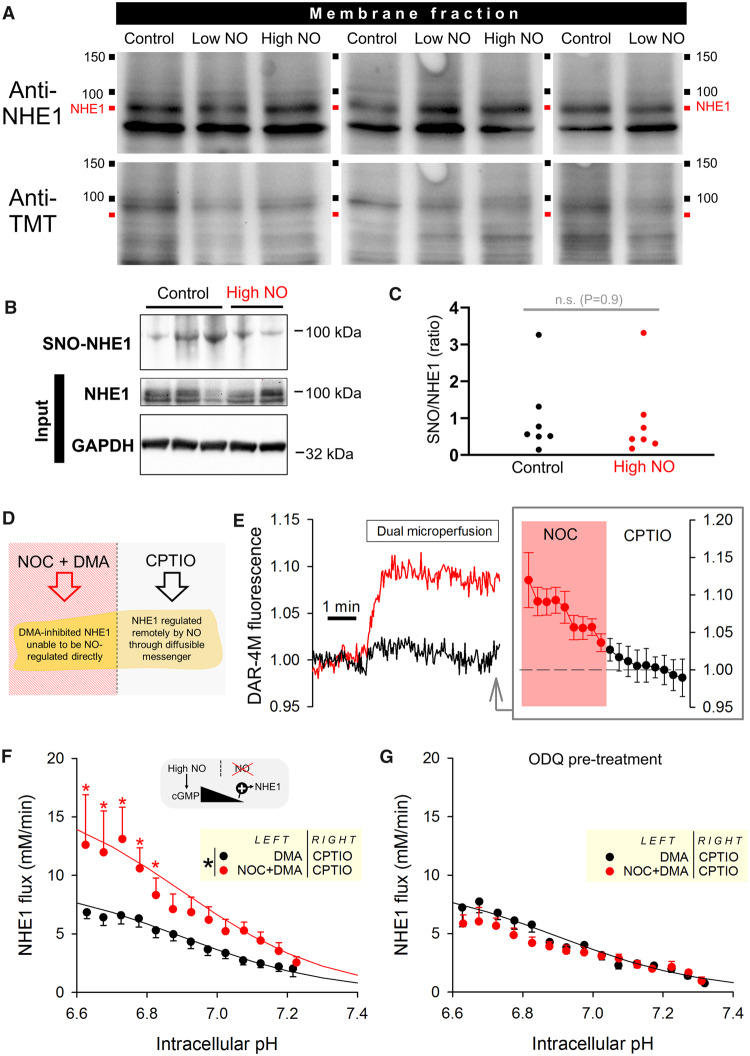
NO regulates NHE1 activity via a diffusible messenger and not via S-nitros(yl)ation. (A) Hearts were Langendorff-perfused with normal Tyrode, or Tyrode with high (5 µM NOC12) or low (300 µM NOC12 + 100 µM CPTIO) [NO]. S-nitros(yl)ation assay was performed on membrane fractions of heart lysates. NHE1 staining visible as bands near 90 kDa. Re-probed for TMT as readout of protein S-nitros(yl)ation: no increase in nitros(yl)ation was detectable in the presence of NO donors. (B) Direct NHE1 S-nitros(yl)ation (SNO) was evaluated by an independent method that uses organo-mercury enrichment. (C) No difference in the extent of SNO-enriched NHE1 was observed between control and high NO-treated hearts. N = 7 per group; not significant (P = 0.9); Mann–Witney U-test. (D) Dual microperfusion of isolated rat myocyte. Left microstream produced a NO microdomain from slow-releasing NOC12 (5 µM); NHE1 was inactivated locally by dimethylamiloride (30 µM). Right microstream contained CPTIO to scavenge any spill-over of NO from the left microstream. (E) Measurement of NO microdomain using fluorescent dye DAR-4M, showing gradient of [NO] along length of cell (N = 9 cells from three animals). (F) NHE1 activity in myocyte determined from the pHi recovery following a uniformly-applied ammonium prepulse. Note the magnitude of flux is lower because NHE1 activity in half of the myocyte is blocked with DMA (N = 14 treated with NOC12; N = 12 control experiments from three animals). High [NO] delivered by NOC12 remotely activated NHE1 (P < 0.0001, two-way ANOVA). (E) Remote signalling between NO and NHE1 was absent in cells pretreated with the GC inhibitor ODQ (5 µM), indicating a role for the diffusible messenger cGMP.